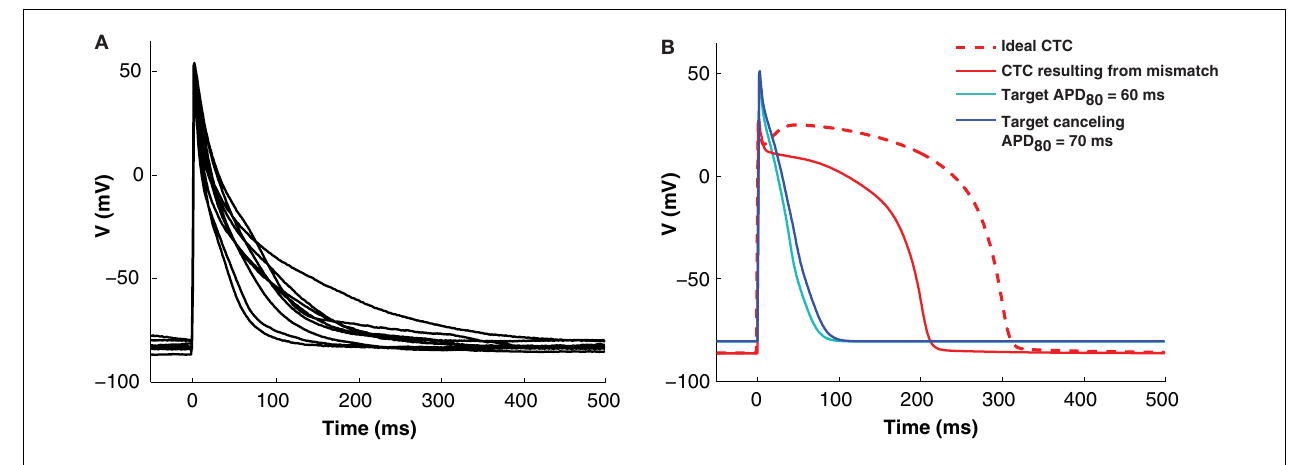
positions produce an ideal conversion to the human recipient model (red, dashed line). However, when a small discrepancy is simulated by perturbing the target-canceling model (to neonatal mouse model with an APD 80 of 70ms; blue) there is imperfect anthropomorphization with insufficient AP prolongation (red, solid